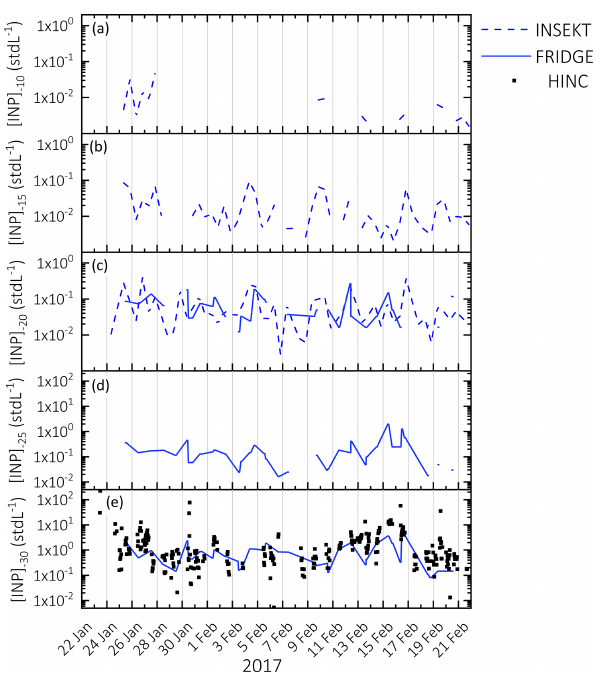
Figure 3. Time series of [INP] measured at (a) − 10 ◦ C (INSEKT), (b) − 15 ◦ C (INSEKT), (c) − 20 ◦ C (INSEKT and FRIDGE), (d) − 25 ◦ C (FRIDGE), and (e) − 30 / − 31 ◦ C (FRIDGE/HINC respec- tively). Elevated [INP] values during 22–27 January and 11–17 February are only detected at temperatures of − 25 and − 30 / − 31 ◦